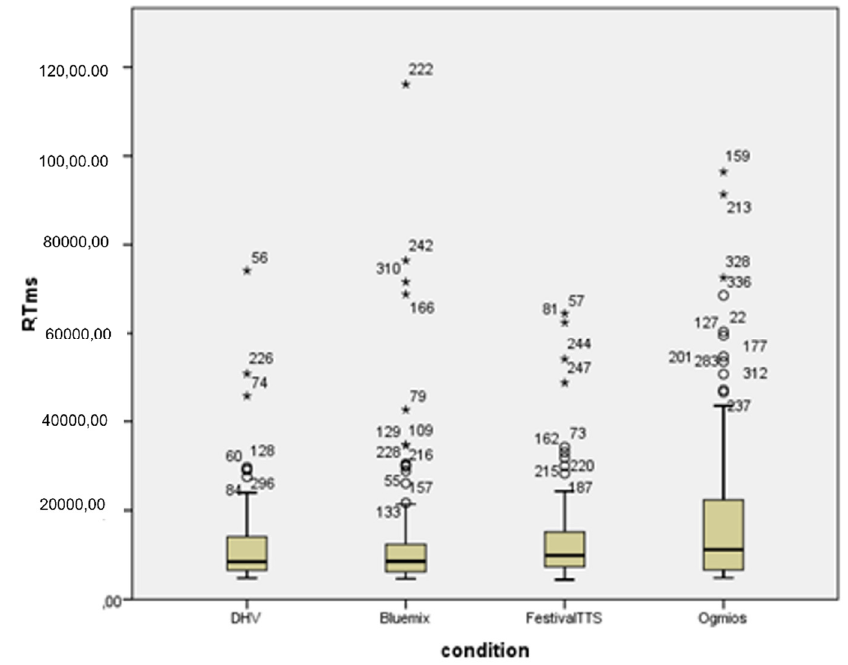
Figure 2. Box plot illustrating the RT distribution of the single items per participant, divided by the four voices. The circles correspond to outliers and the asterisk to extreme outliers.